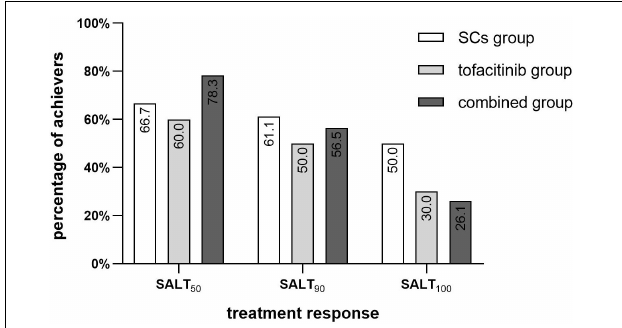
FIGURE 1 | Percentage of SALT 50 , SALT 90 , and SALT 100 achievers in the SCs group ( n = 18), the tofacitinib group ( n = 20), and the combined group ( n = 23). SCs, systemic corticosteroids; SALT, Severity of Alopecia